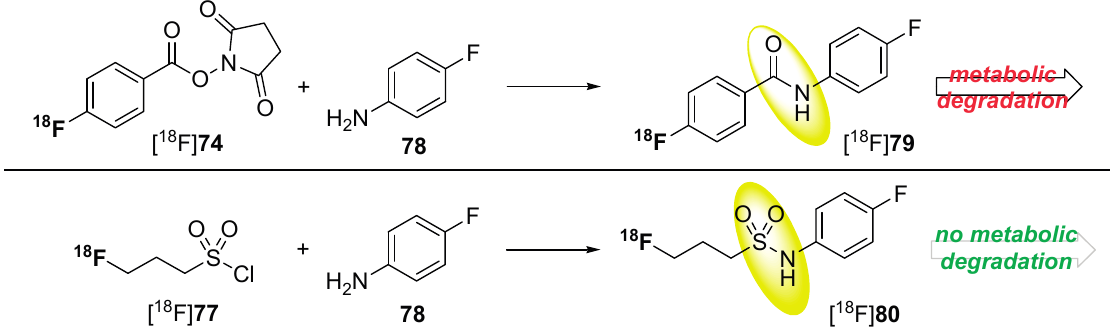
Scheme 23. Comparison in radiofluorination and metabolic stability for [ 18 F]SFB [ 18 F] 74 and [ 18 F]fluoropropylsulfonyl chloride [ 18 F] 77